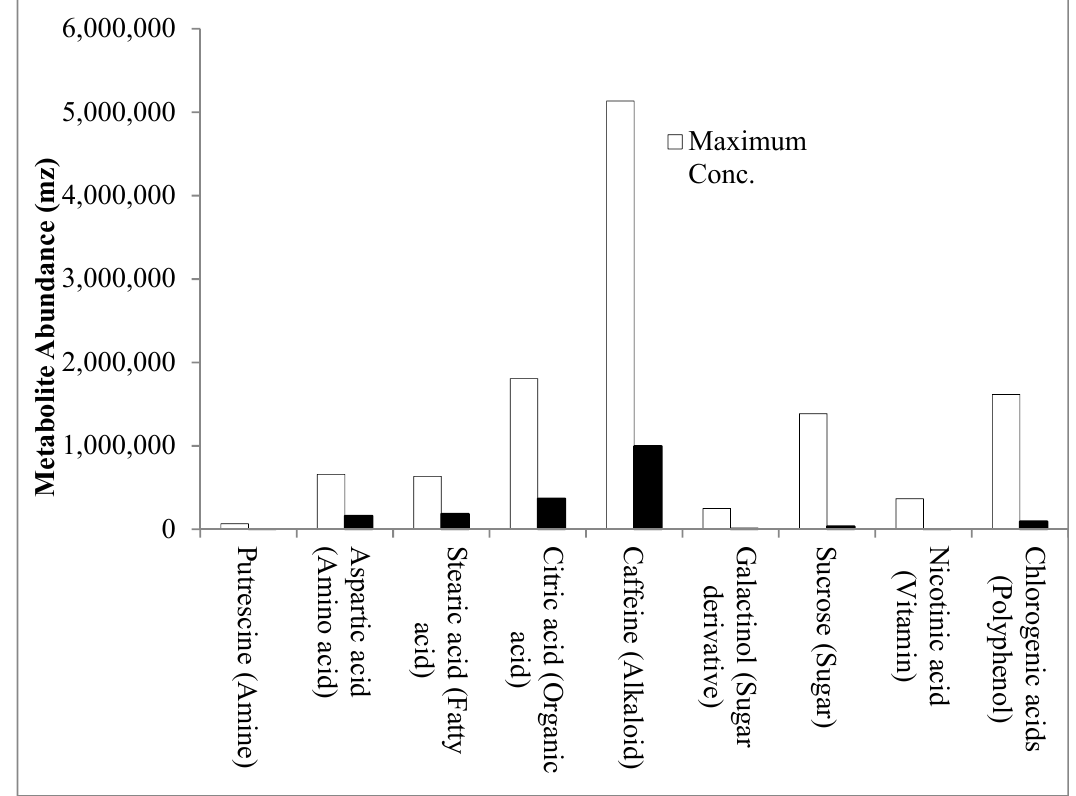
Figure 1. Variation in the relative abundance of coffee metabolites across genotypes. Metabolites that occur with maximal abundance within each of the eight main metabolite classes are indicated by the white bars. Also shown (indicated as a black bar) is the minimal abundance of that metabolite across genotypes.